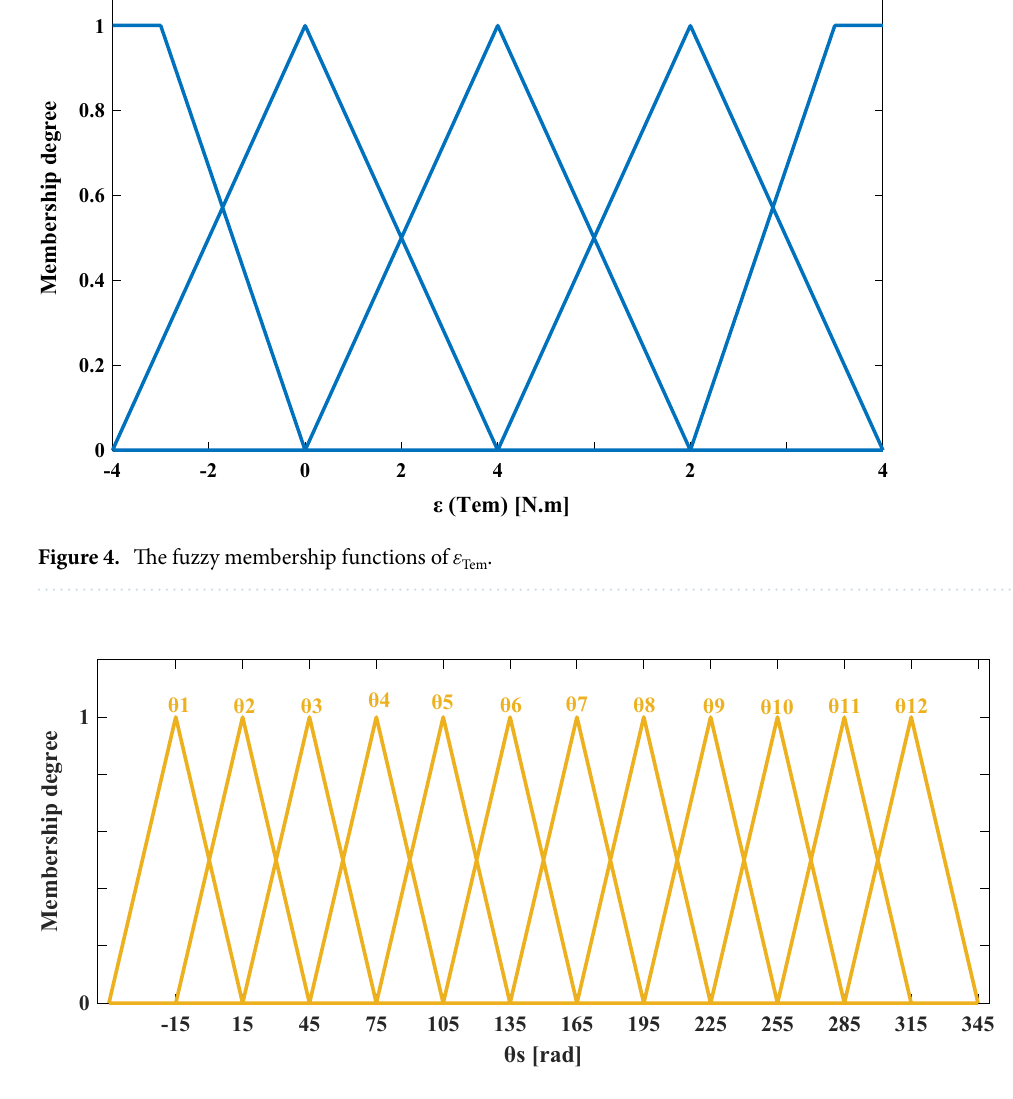
Figure 5. The fuzzy membership functions of θ s